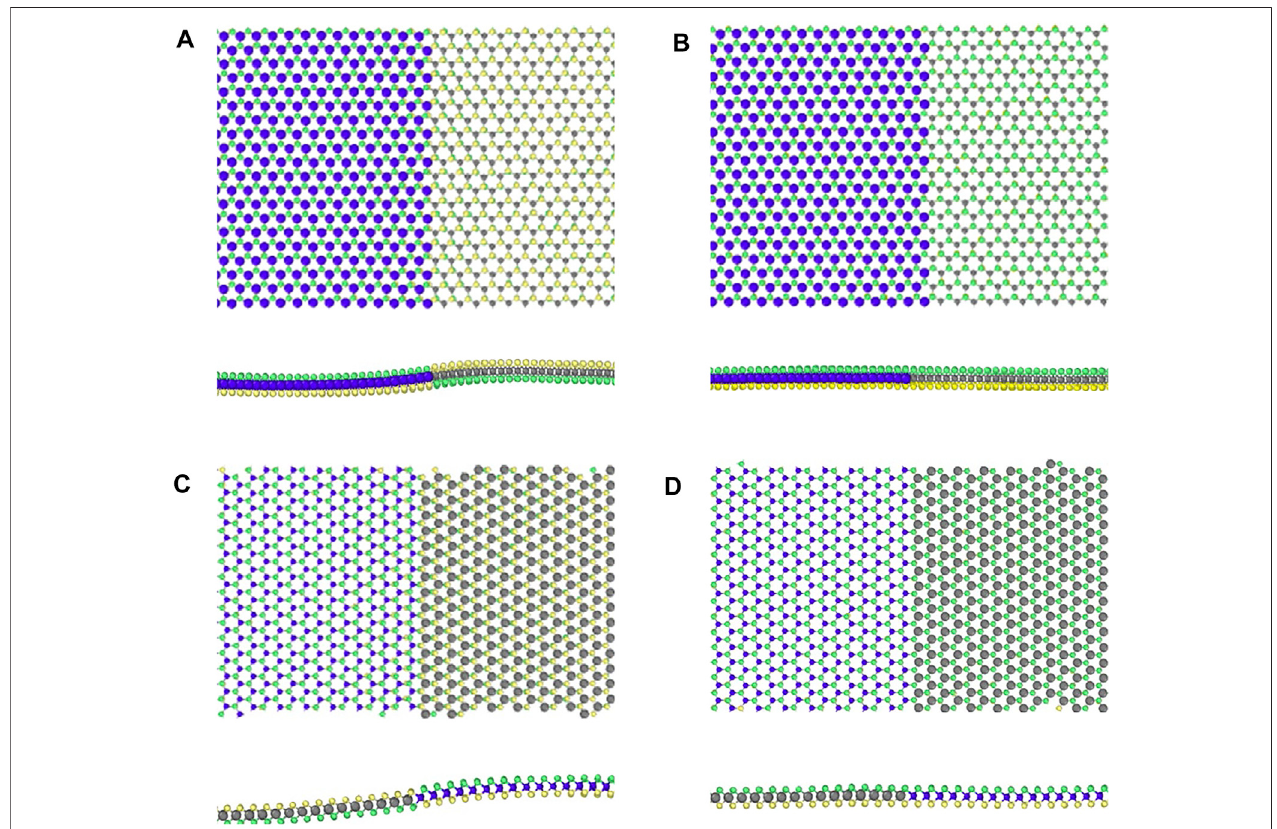
FIGURE 2 | MD snapshot for the structures of the (A) arm-1, (B) arm-2, (C) zig-1, and (D) zig-2 MoSSe/WSSe heterostructures at 300 K.